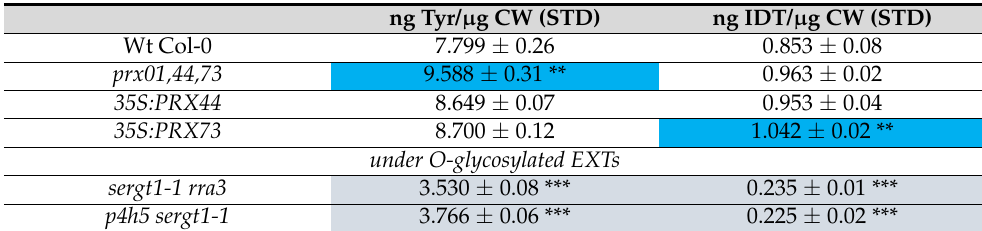
Table 1. Peptidyl-Tyr and iso-dityrosine (IDT) contents in cell walls isolated from Wt Col-0, prx01,44,73 triple mutant, 35S:PRXs lines, and mutant lines with under-glycosylated EXTs. p -values were determined by one-way ANOVA, (***) p < 0.001, (**) p < 0.01. STD = standard deviation. Values significantly different than Wt Col-0 are highlighted in blue if higher and in light blue if lower than Wt Col-0. ng Tyr/ µ g CW (STD) ng IDT/ µ g CW (STD) Wt Col-0 7.799 ± 0.26 0.853 ± 0.08 35S:PRX44 8.649 ± 0.07 0.953 ± 0.04 35S:PRX73 8.700 ± 0.12 1.042 ± 0.02 ** under O-glycosylated EXTs sergt1-1 rra3 0.225 ± 0.02